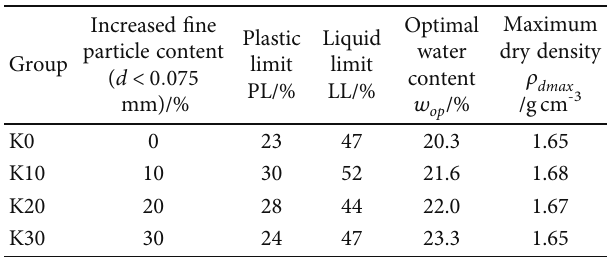
Figure 1: A schematic diagram of characterizing the shakedown ranges of the permanent strain development of a granular material under cyclic loading. Table 1: The physical parameters of soil.